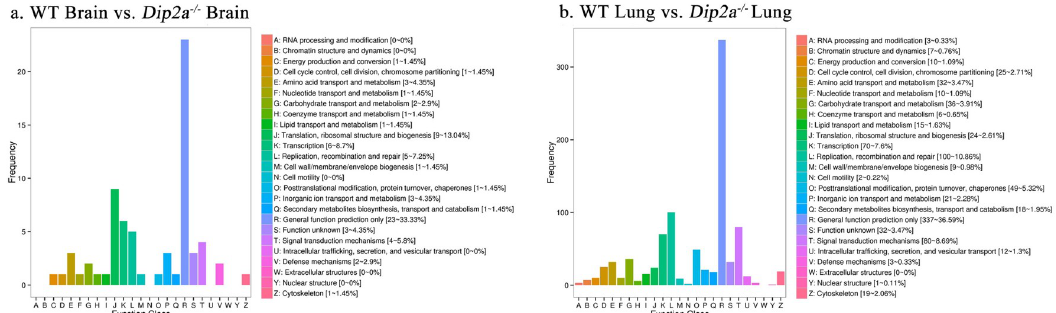
Fig 5. COG classification of differential expression genes (a) WT brain vs. Dip2a -/- brain and (b) WT lung vs. Dip2a -/- lung. The X-axis indicates content of each category of COG and the Y-axis indicates number of genes annotated in each category.